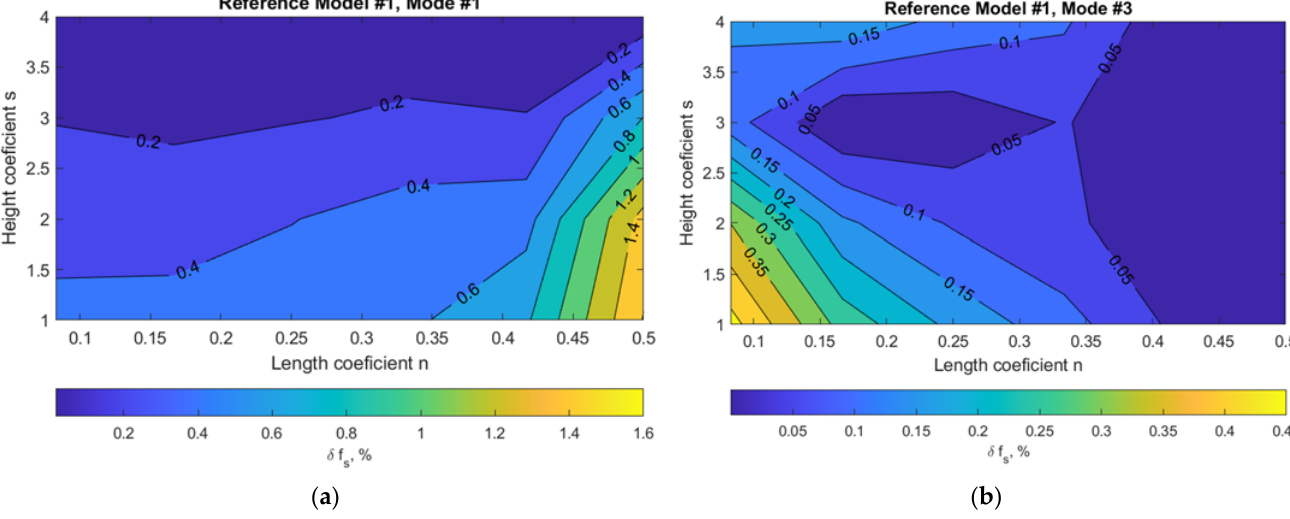
Figure 7. Variation of structural frequency f s due to damage scenario for reference nine-story model #1: ( a ) mode #1 (lateral); ( b ) mode #3 (torsional).